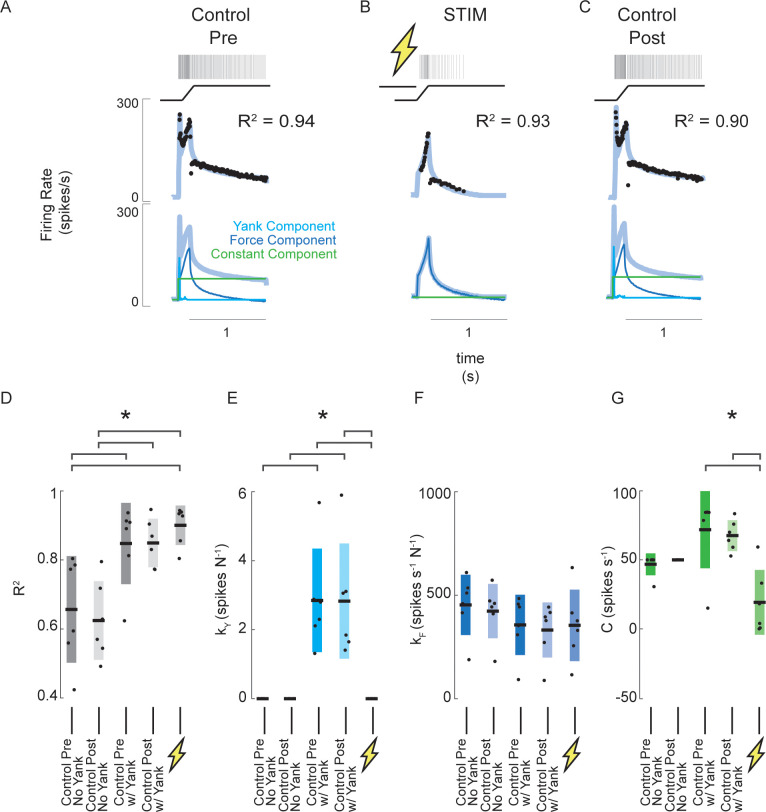
Estimated muscle fiber force-related model predicts changes in muscle spindle encoding caused by axonal stimulation.(A) Example of pre-stimulus control trial consisting of a 3 mm ramp-hold stretch at 20 mm/s. Raster represents the times of recorded action potentials in response to the ramp-hold stimulus shown directly below it. Black dots represent the afferent IFR corresponding to the raster. The gray-blue line represents the model prediction using force, yank, and constant components. Below this are the same model prediction as above (gray-blue) and model prediction components (blue – force component; cyan – yank component; green – constant component). (B) Example of stimulus trial consisting of the same stretch applied as A, with a train of antidromic action potentials induced by suprathreshold current injection into the Ia axon prior to stretch. The model fit in this trial represents the best fit without the yank component. Notice the quality of fit does is roughly equal in this trial with that of the pre-stimulus trial in A, but no yank component was necessary. (C) Example of post-stimulus control trial. Same stretch and model components were used as in A. (D) Goodness of fit (R2) of force-related model for six afferents subjected to the same trials as shown in A-C. The first two columns show R2 values of the model fits without yank components for the pre- and post-stimulus control trials, respectively, for all six afferents. The third and fourth columns from the left show R2 values for the model fits with yank components for the pre- and post-stimulus control trials, respectively, for the same six afferents. The fifth column shows R2 values for the model fits for the stimulus trials. This model did not use a yank component. (E) Model sensitivity to yank for the same model fits and afferents as D. (F) Model sensitivity to force for the same model fits and afferents as D and E. (G) Model constant component for the same model fits and afferents as D-F. Brackets above plots indicate significant differences between the means (p<0.05).